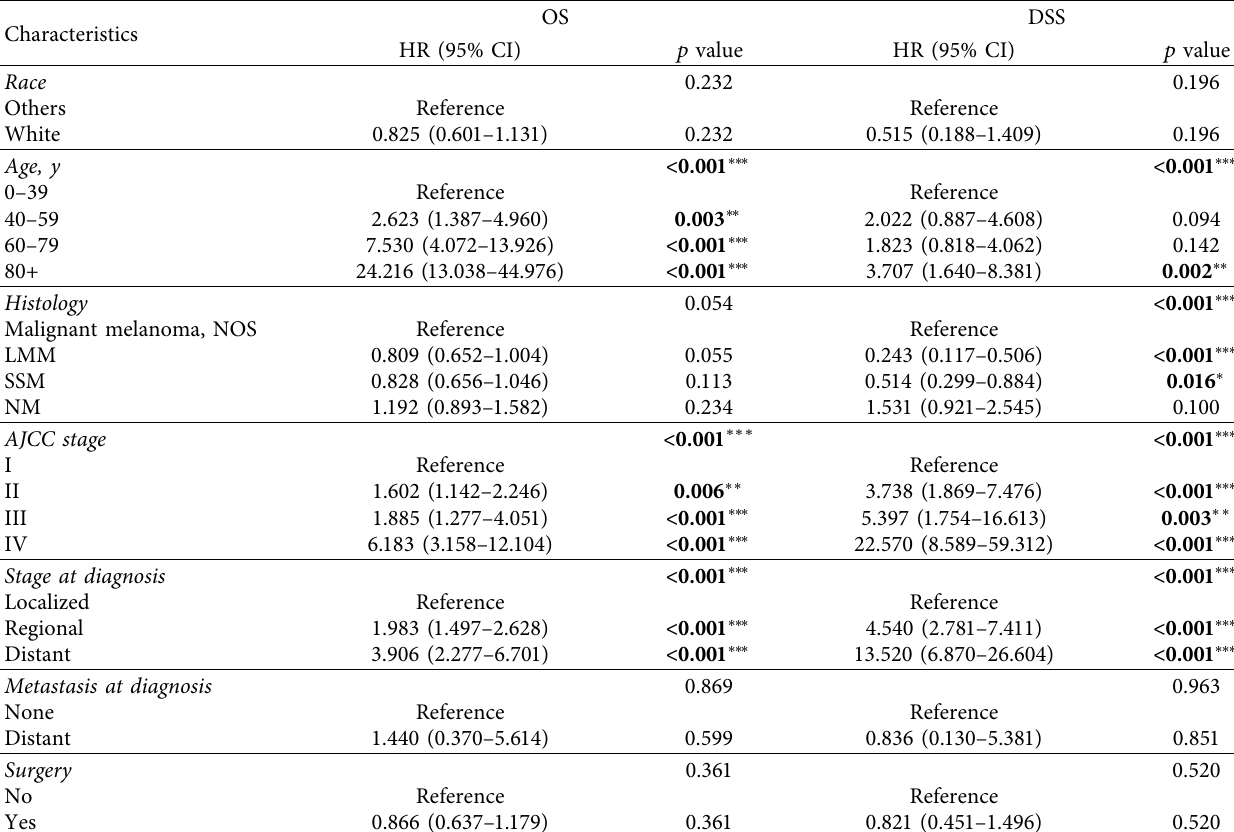
Table 3: Multivariate cox proportional hazard regression analysis of prognostic factors for OS and DSS of patients with eyelid PMM.